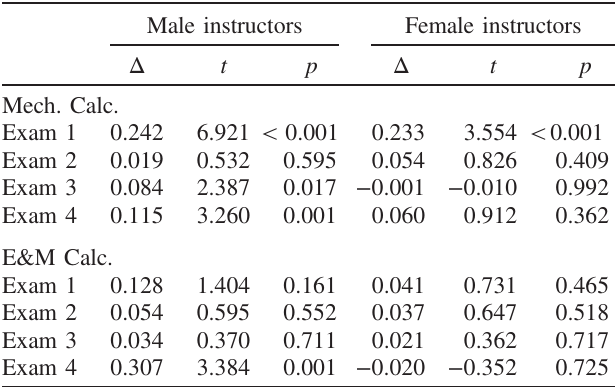
TABLE VII. Average z -score differences between male and female students, Δ , separated by instructor gender, as well as the t tests and significances between these distributions.